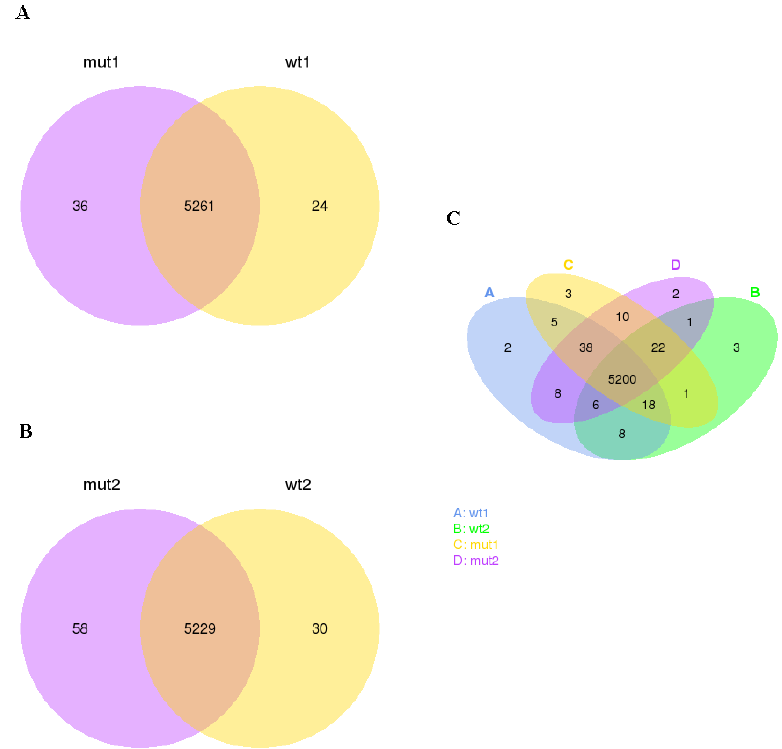
Figure 1. Gene co-expression. Venn diagrams depicted number of common and uniquely expressed genes in WCS358 wild type and ∆ rclS mutant ( A ) in exponential growth phase; ( B ) in stationary growth phase; ( C ) in exponential and stationary growth